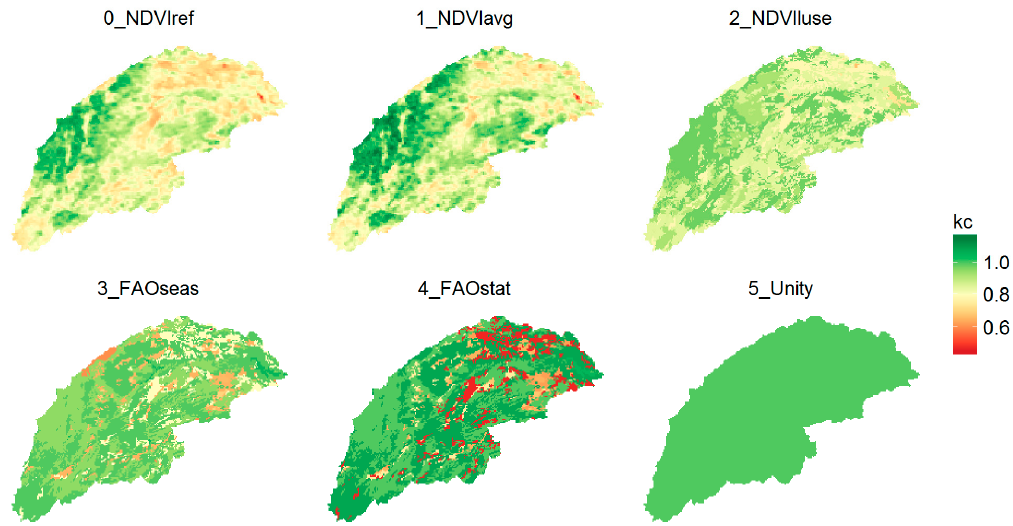
Figure 2. Maps of the mean annual crop coefficient for the different parameterization methods